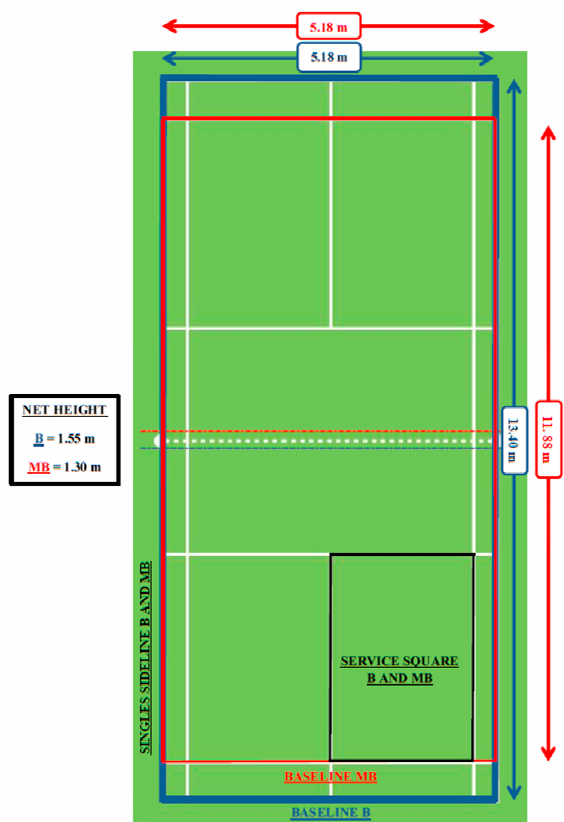
Figure 1. Illustration of net height and court dimensions in both competitions (Badminton formal format “B” = blue color and Mini-Badminton “MB” = red color).